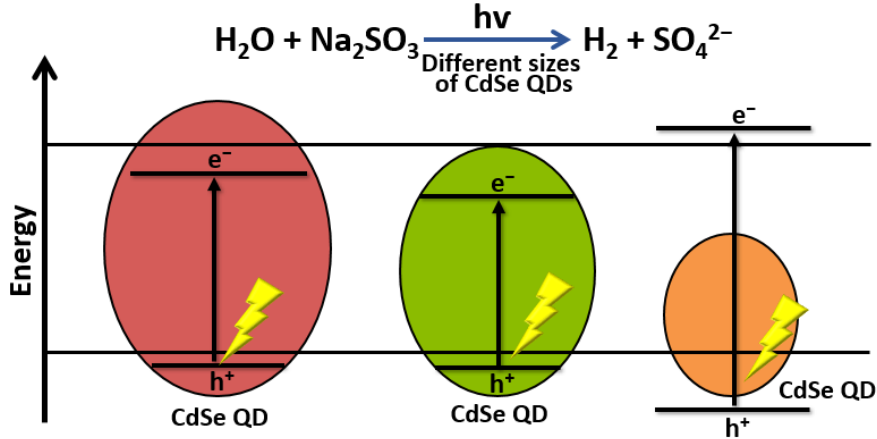
Figure 6. Schematic illustration of the effect of CdSe QD size in photocatalytic H 2